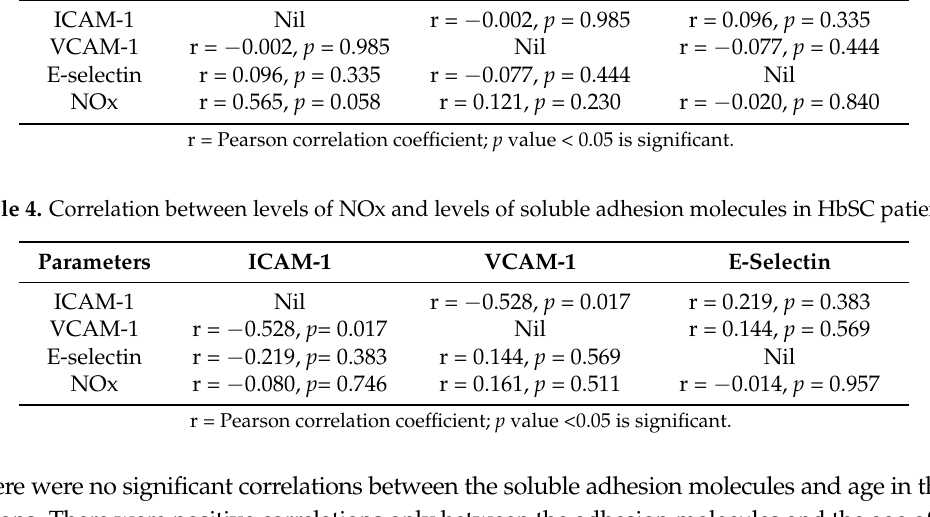
Table 3. Correlation between levels of NOx and levels of soluble adhesion molecules in HbSS patients. Parameters